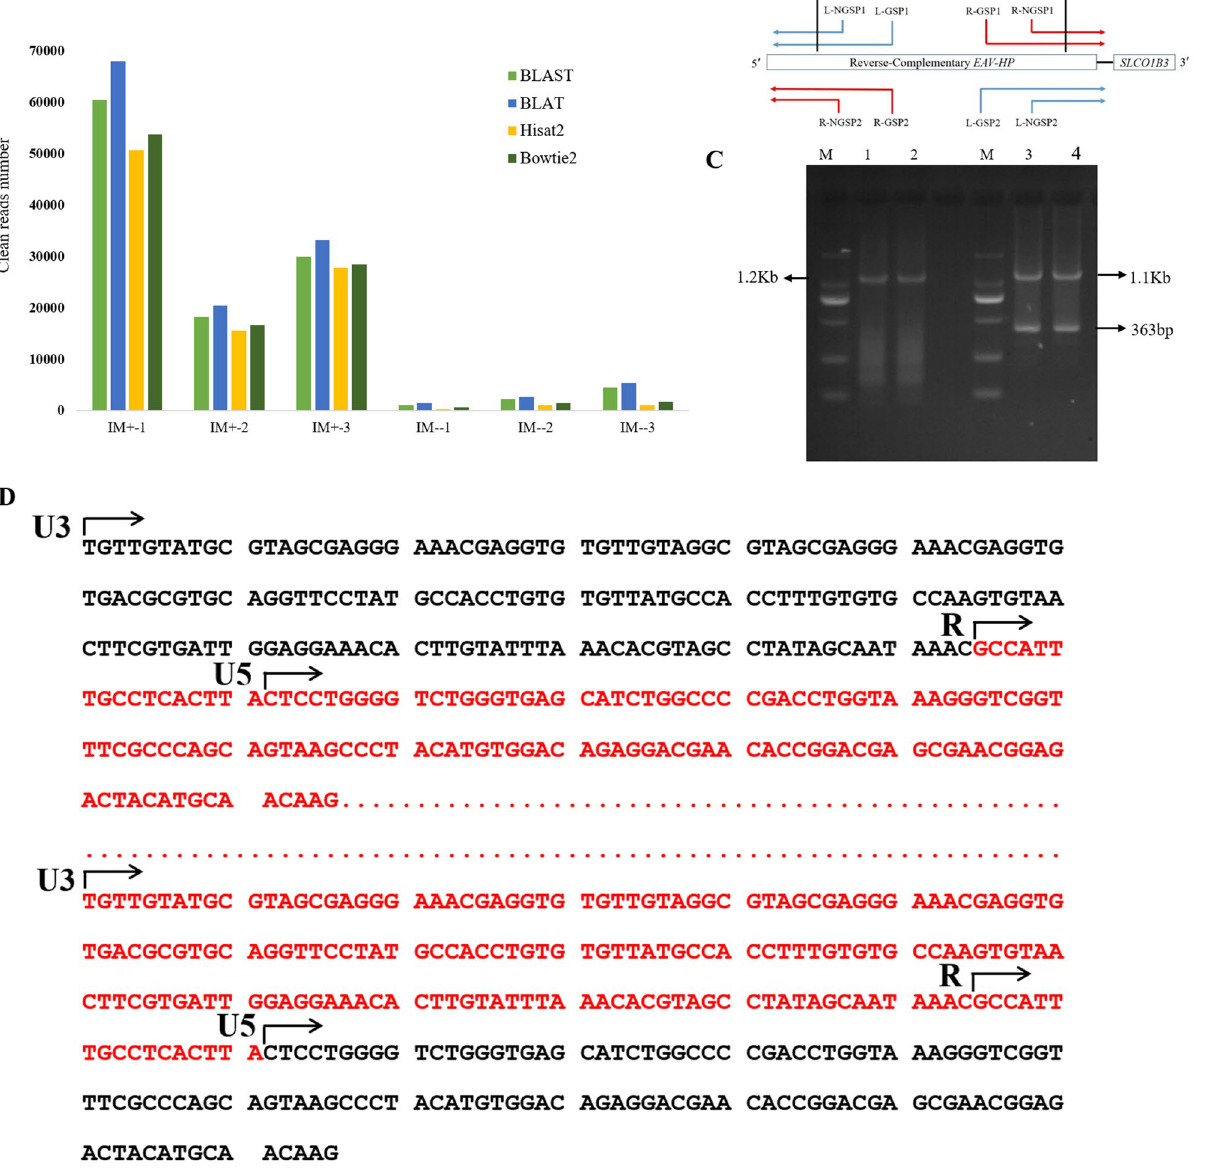
controlling the amount that endogenous and exogenous substances are transferred (including bile acids, thyroid hormone, estrogens, etc.) into the liver cells. Although some transcription factors (e. g., ESR and PPAR) were not significantly expressed or detected in the RNA-seq and proteome.